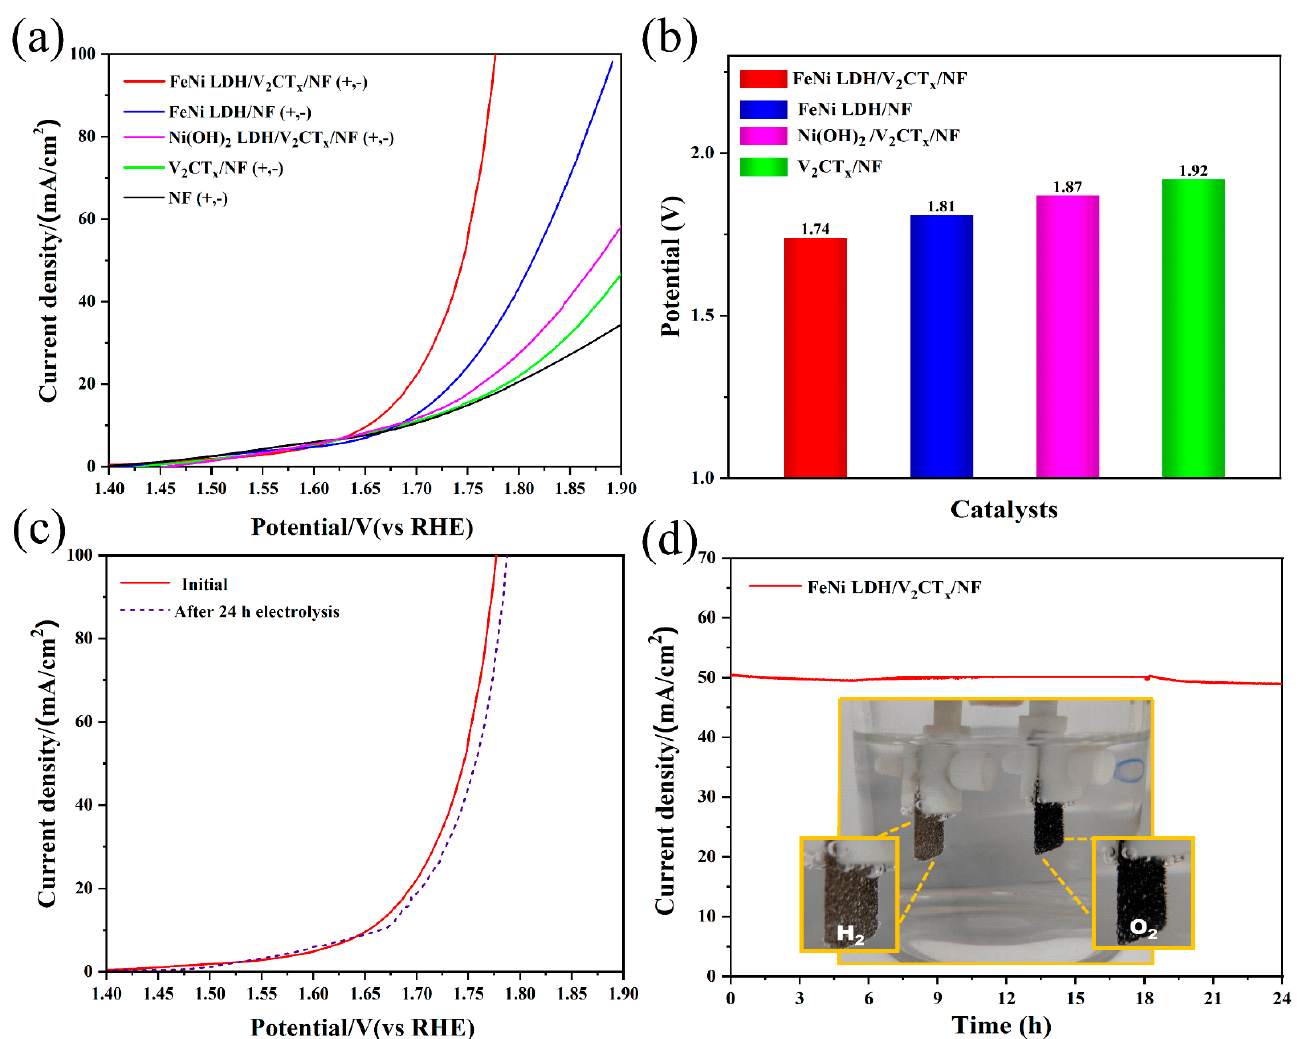
Figure 5. Overall water splitting performances of synthesized electrocatalysts. ( a ) LSV curves. ( b ) The voltage of electrocatalysts for overall water splitting. ( c ) LSV curves of FeNi LDH/V 2 CT x /NF before and after 15 h of electrolysis. ( d ) Stability measurements of FeNi LDH/V 2 CT x /NF. The inserted image shows the simultaneous production of H 2 and O 2 bubbles.